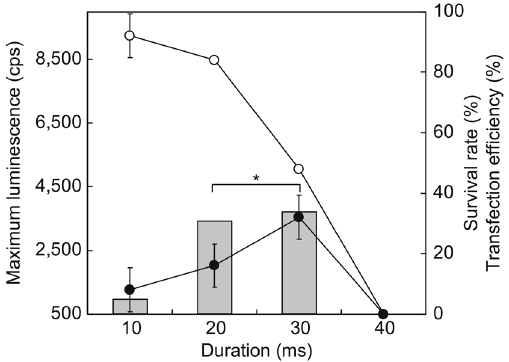
Figure 5. Effect of pulse duration using a 7 mm diameter electrode on survival rate and transfection efficiency of E. fetida . The electroporation conditions were 35 V and 1 pulse/s at 0 s intervals for each duration. All experiments were performed using three groups of eight randomly selected mature earthworms. Open circles, survival rate; closed circles, transfection efficiency; bar graphs, maximum luminescence intensity. * p < 0.05.